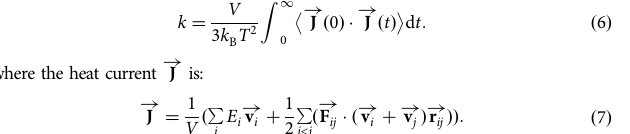
Uncertainty quanti fi cation . The uncertainty in G stems from the uncertainty in the measured heat fl ux and the uncertainty in the measured total temperature drop between two interfaces of graphene foam. According to the Fourier ’ s law, the uncer- tainty in the measured heat fl ux is due to the uncertainty in the thermal conductivity of reference (which is 10% of reported value) and in the temperature gradient in the reference regions. In the IR temperature measurements, the accuracy of temperature gradient is in fl uenced by the accuracy of T-type thermocouple which is used to measure the reference temperature T ref for the emissivity calibration. Another factor impacting the uncertainty in the reference temperature gradient is the manual selection of the reference regions. The uncertainty of total temperature drop across the sample is also impacted by the manual selection of the region with the foam. Speci fi cally, it is quanti fi ed by shifting the manually selected reference-sample interface by several pixels. Ultimately, the combined uncertainty is evaluated by the uncertainty propa- gation approach. The combined uncertainty in the thermal conductance of graphene foam with three compression levels is represented by the error bars shown in Fig. 3d in